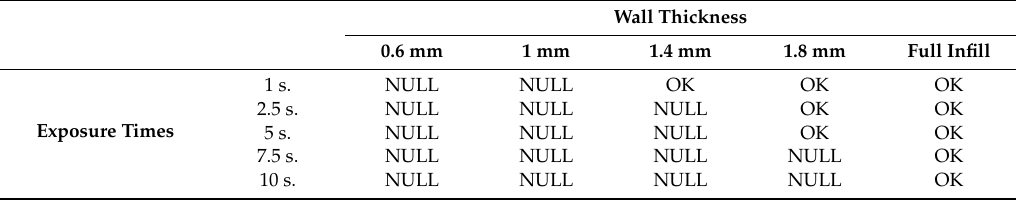
Table 9. Simple compression strength test for di ff erent wall thicknesses and exposure times with a layer height of 0.30